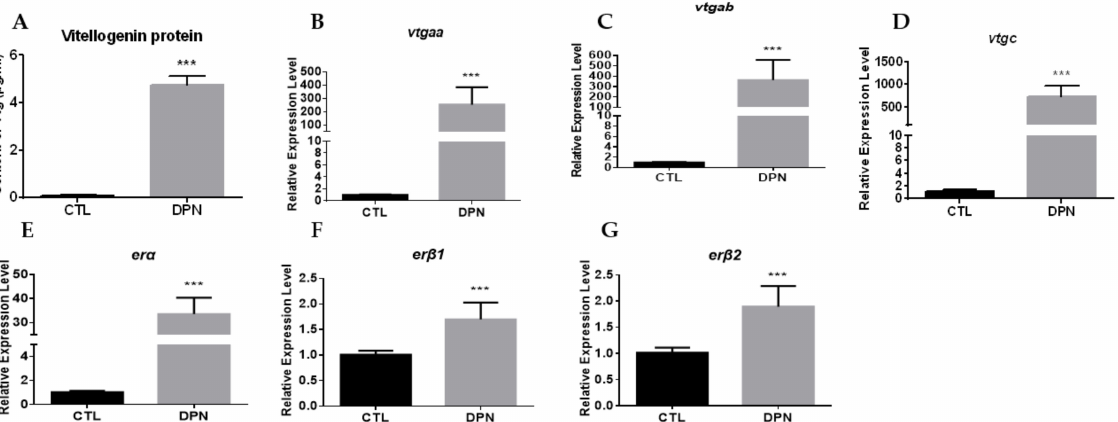
Figure 5. Effects of Cyclofenil (1 µ M) on the expression of vtgs and ers in primary hepatocytes: ( A ) VTG protein levels in the hepatocytes; ( B – G ) the mRNA levels of vtgaa , vtgab , vtgc , er α , er β 1 and er β 2 in the hepatocytes. Data are expressed as the mean ± SEM ( n = 4) and analyzed by one-way ANOVA followed by Tukey’s post-hoc test. Different letters above the error bars indicate statistical differences at p < 0.05.